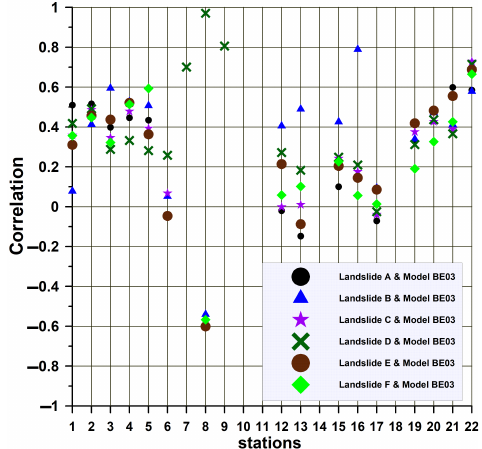
Figure 9. Correlation between simulation for total number landslides (BE-3) and computation for separate